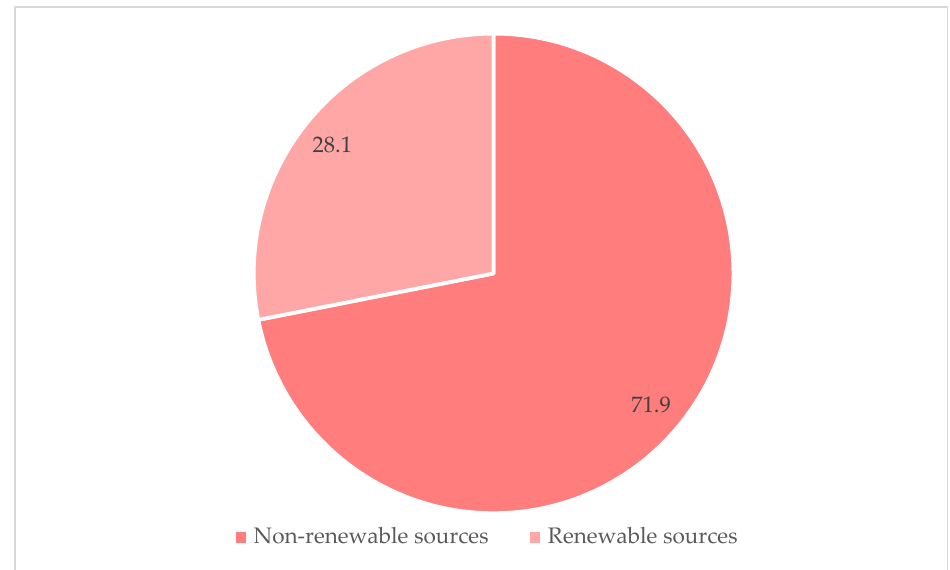
Figure 1. Share of renewables in electricity generation. 2021 г ., % [8].